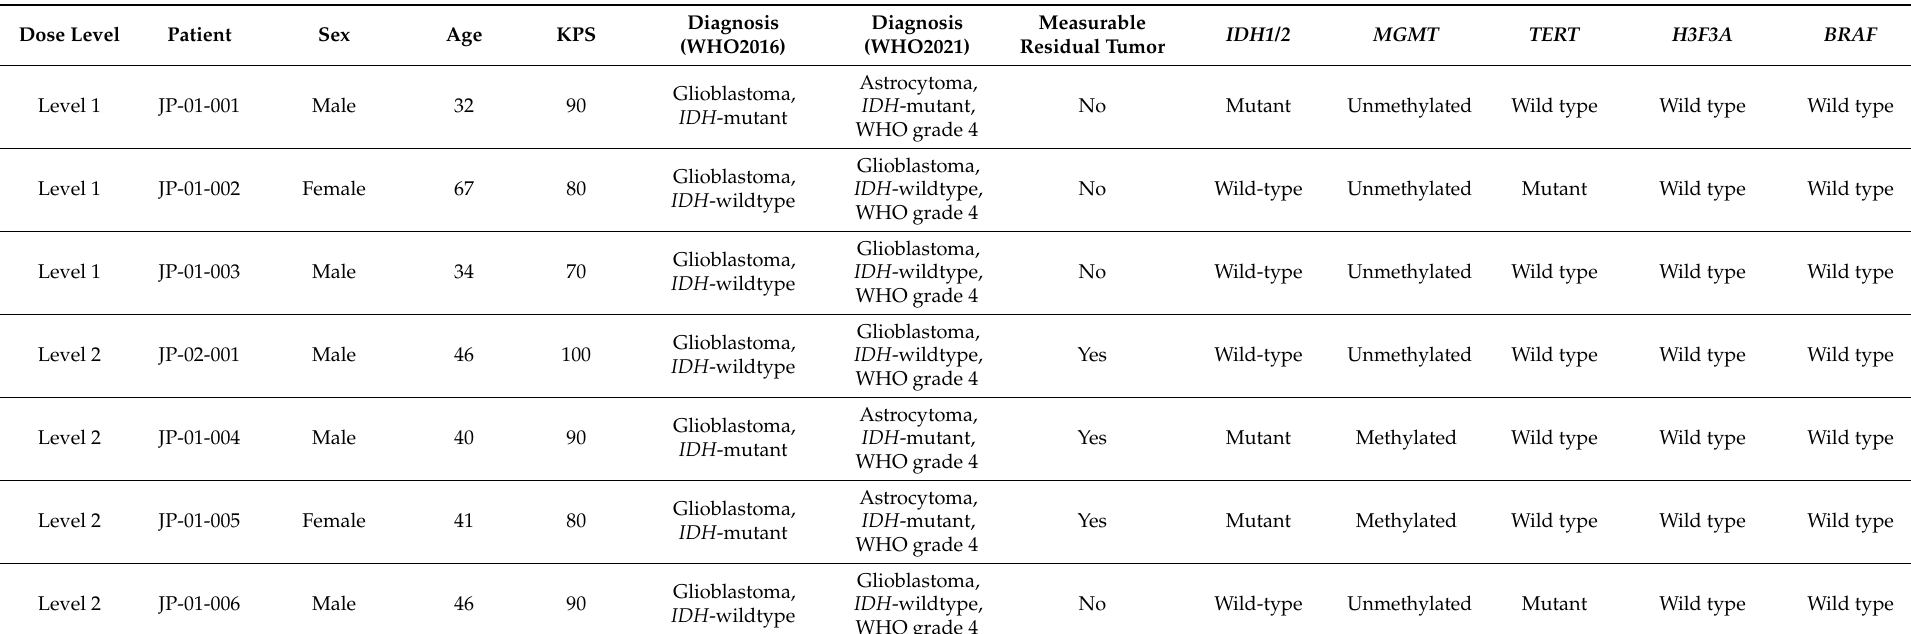
Table 2. Characteristics of the 7